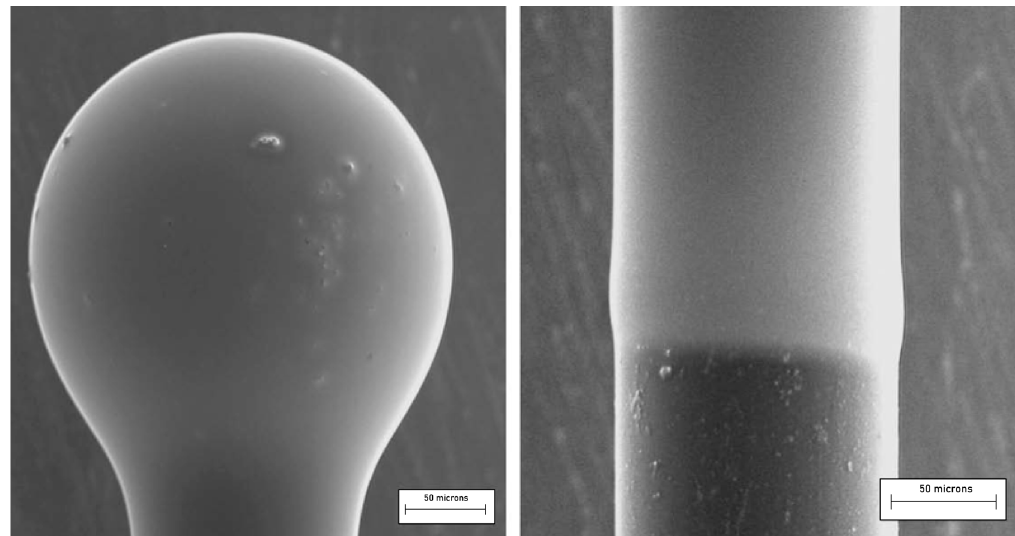
Figure 13. Micrograph of a silica microsphere coated with a 70SiO 2 –30HfO 2 thin film and activated with erbium ions ( left ). The coating of a portion of the fiber stem ( right ) permits us to estimate the thickness of the deposited film. Reproduced with permission from [94], copyright 2009, Elsevier.